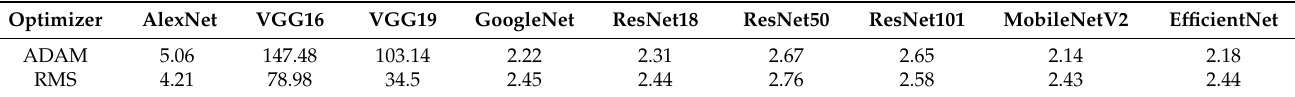
Figure 6. The network training parameters setup is as follows: learning rate: 0.001, epochs: 30, minimum batch size: